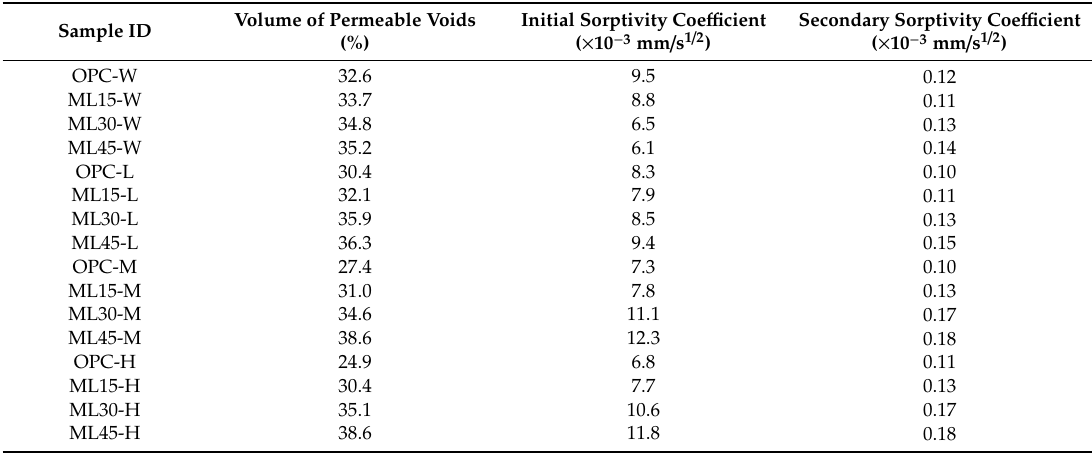
Table 5. Volume of permeable voids and sorptivity coe ffi cients of the samples under various curing